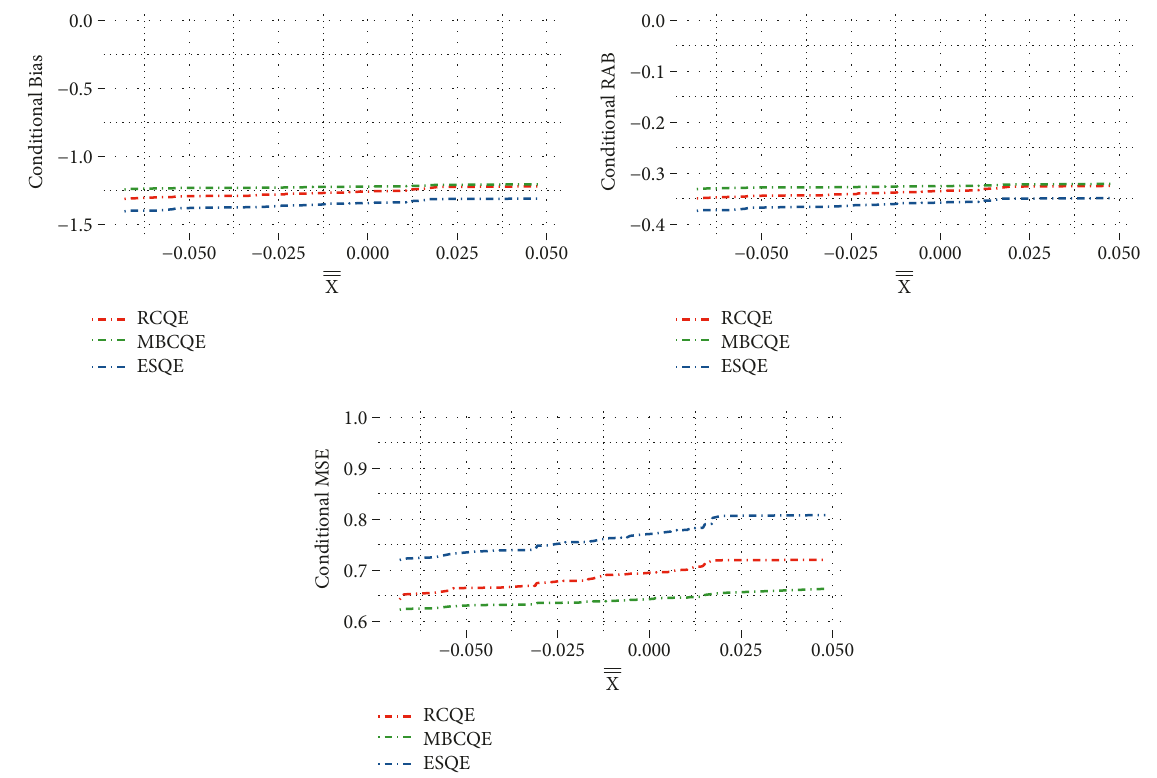
Figure 6: CB, CRAB, and CMSE for estimators: cosine mean function, α � 0 .